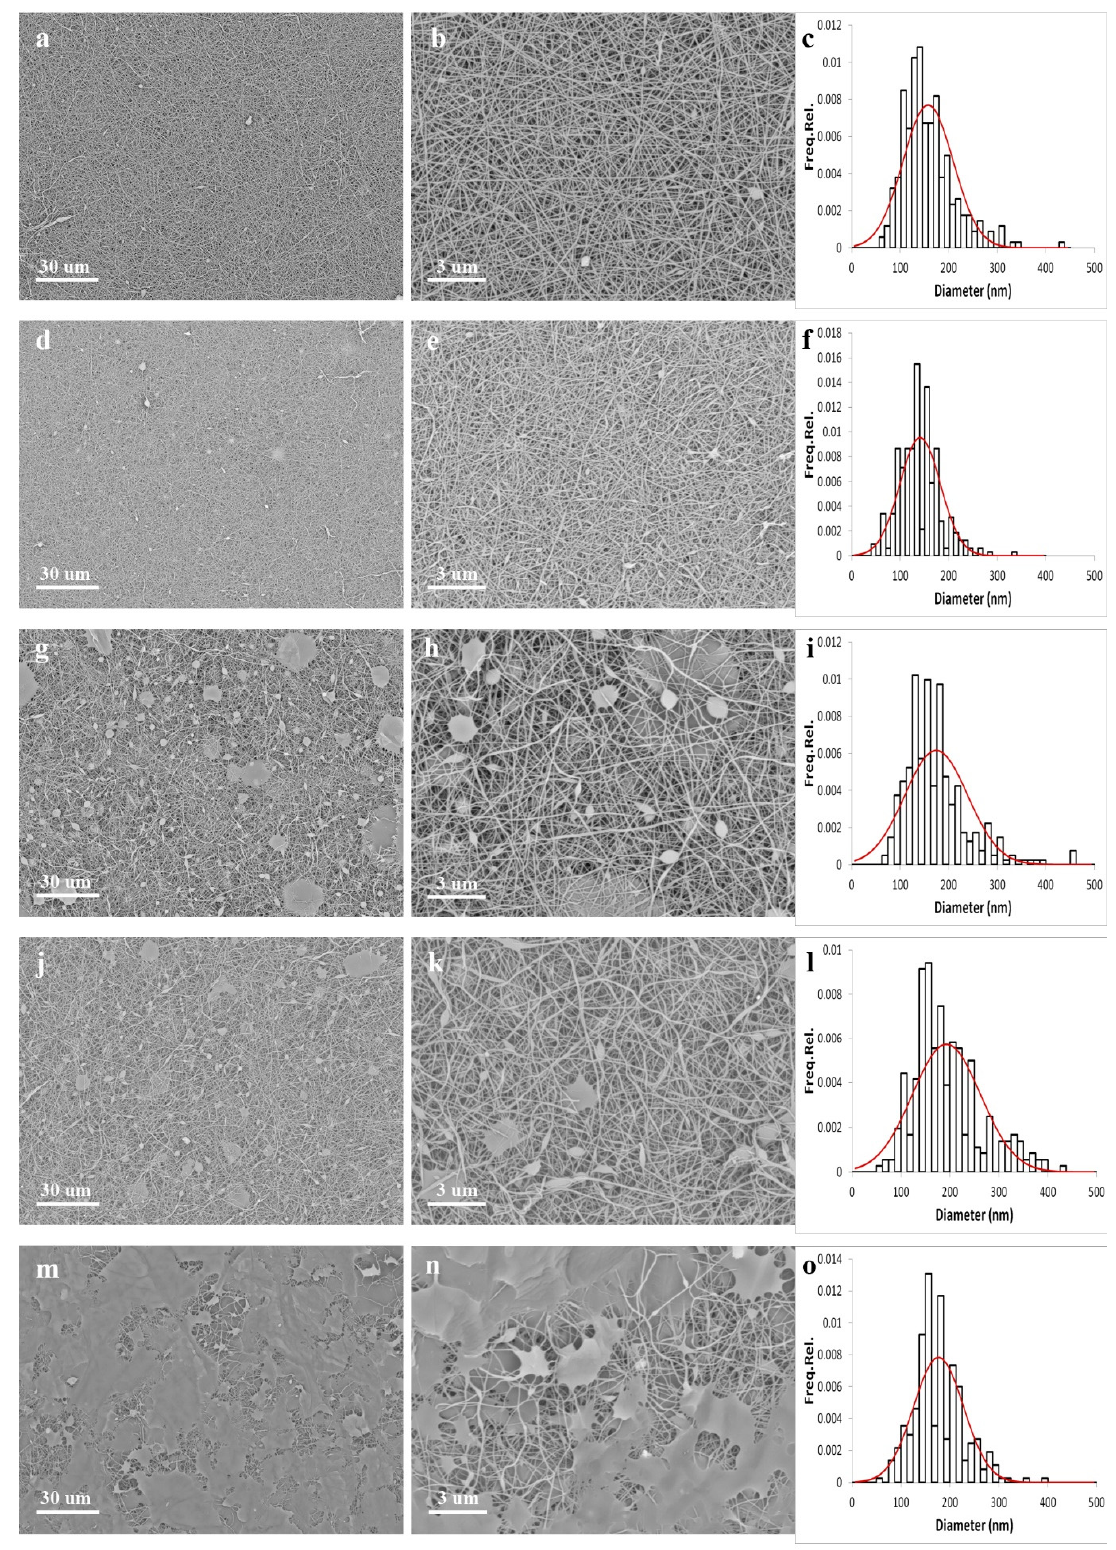
Figure 6. SEM micrographs and related nanofiber dimension distribution for ( a – c ) annealed PVA fibers, ( d – f ) annealed PVA-AuNPs 1 fibers, ( g – i ) annealed PVA-AuNPs 2 fibers, ( j – l ) annealed PVA-AuNPs 3 fibers, and ( m – o ) annealed PVA-AuNPs 4 fibers.